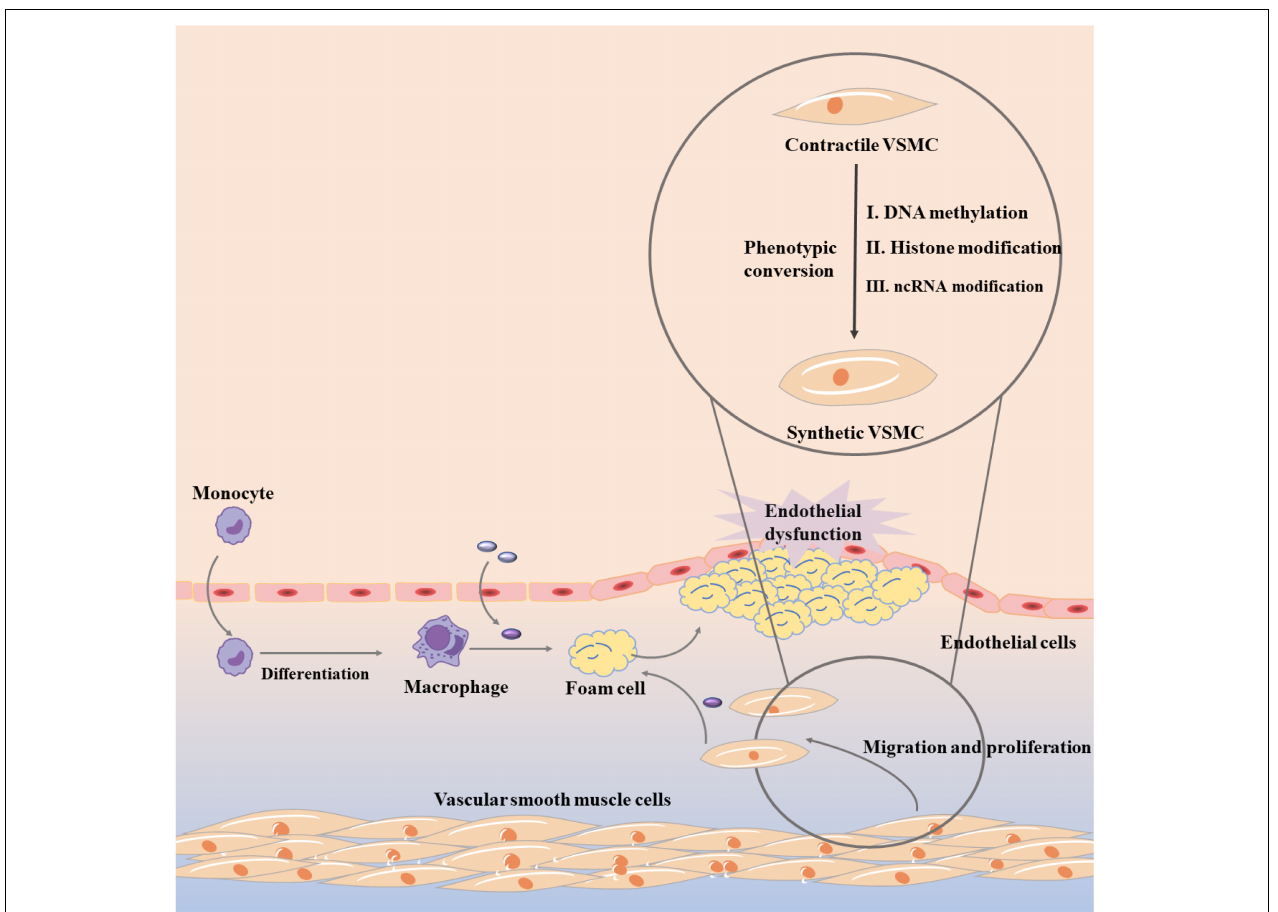
FIGURE 3 | Vascular smooth muscle cell phenotypic conversion in